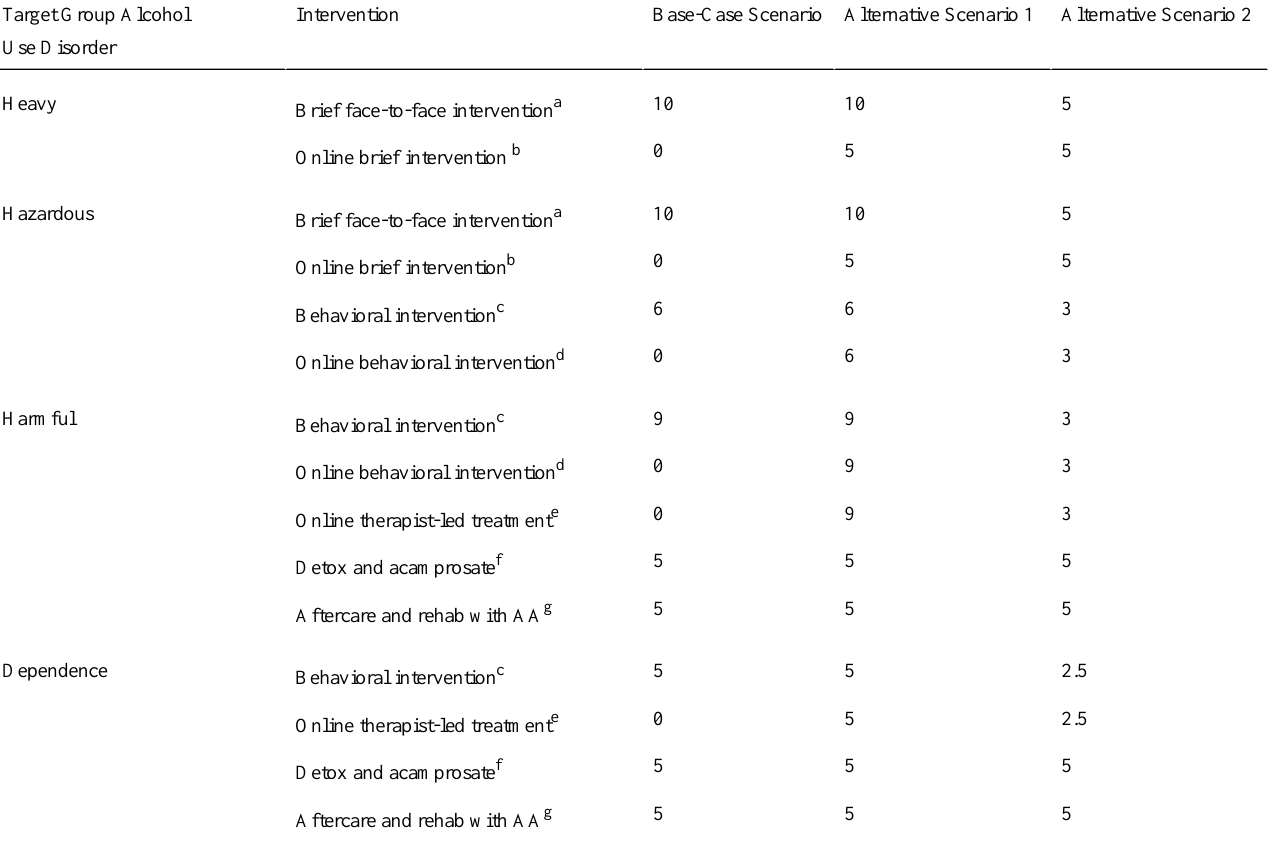
Table 1. Modeled scenarios: coverage rates (%) for each of the